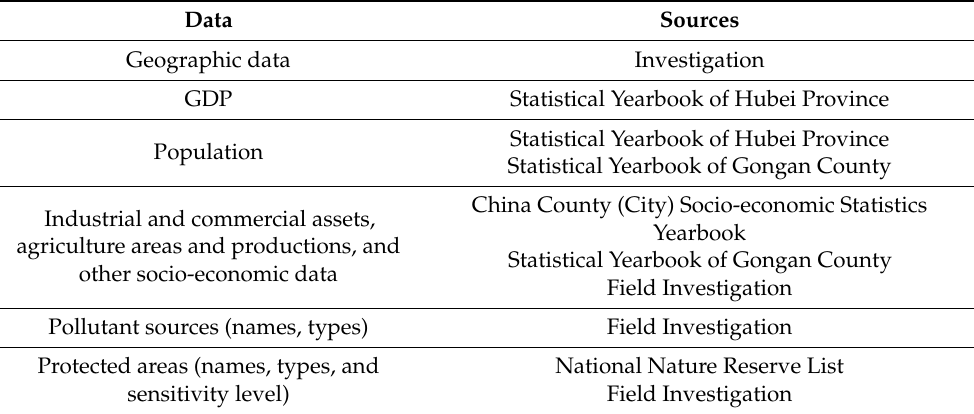
Table 4. Socio-economic and environmental